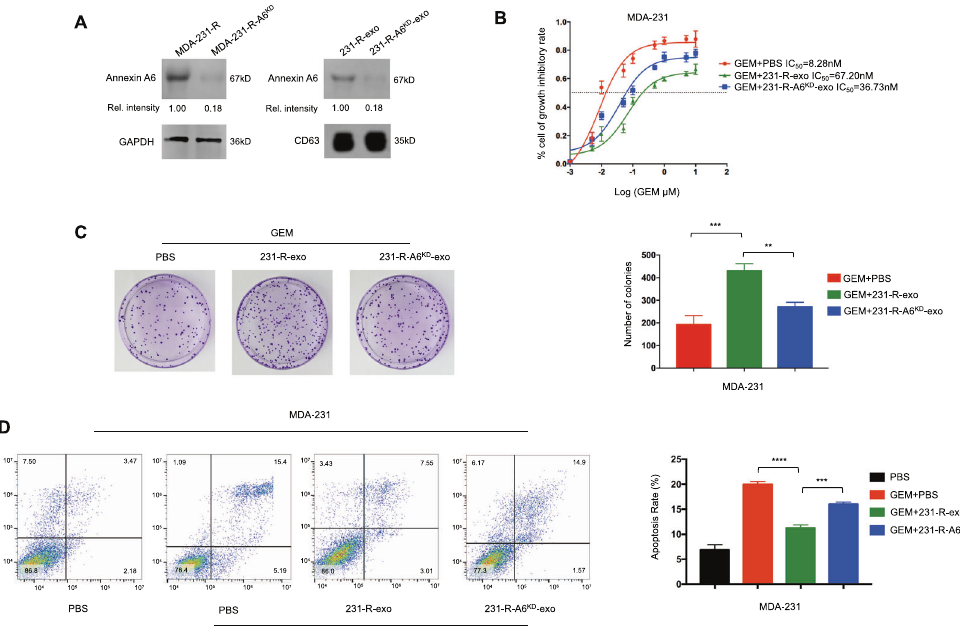
Fig. 4 Knockdown Annexin A6 (ANXA6) rescues exosome-induced gemcitabine resistance. A ANXA6 expression was reduced in ANXA6- knockdown MDA-231-R cells (MDA-231-R-A6 KD ) and their exosomes (231-R-A6 KD -exo). B IC 50 values determined using the CCK-8 assay in MDA- 231 cells treated with GEM + PBS, GEM + 231-R-exo, or GEM + 231-R-A6 KD -exo for 48 h. C Colony formation in MDA-231 cells treated with GEM + PBS, GEM + 231-R-exo, or GEM + 231-R-A6 KD -exo for 24 h and incubated for 7 days. D Flow cytometric analyses of apoptosis in MDA- 231 cells treated with PBS, GEM + PBS, GEM + 231-R-exo, or GEM + 231-R-A6 KD -exo for 24 h. All experiments were repeated three times, and the representative results are presented. Quantitative data are presented as the mean ± SD of triplicate experiments. P < 0.05, ** P < 0.01, *** P < 0.001, and **** P <